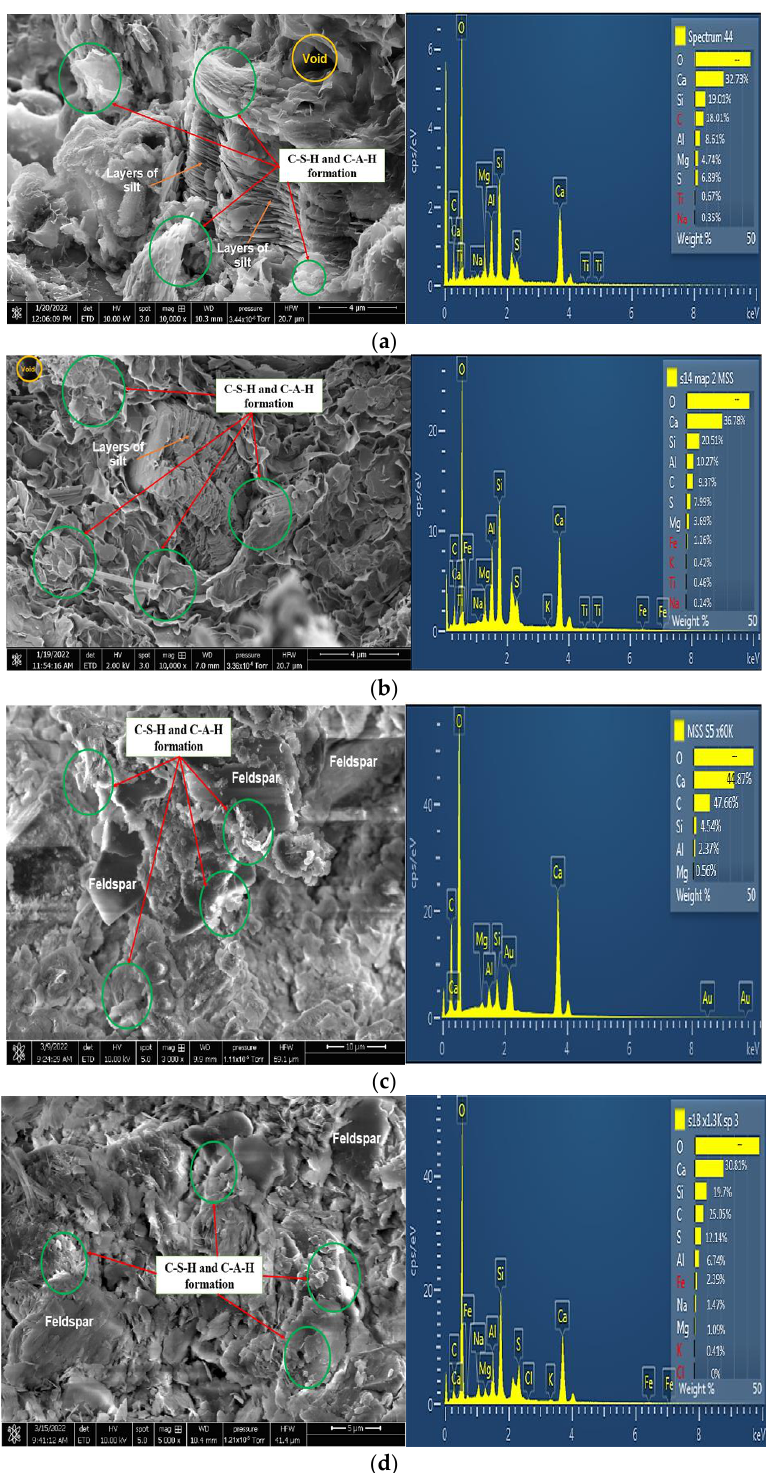
Figure 8. ( a ) SEM and EDX results for subgrade 1 composed of 11.75% GGBS and 11.75% BDW after 28 days curing. ( b ) SEM and EDX results for subgrade 2 composed of 11.75% GGBS and 11.75% BDW after 28 days curing. ( c ) SEM and EDX results for subgrade 1 composed of 23.5% GGBS after 28 days curing. ( d ) SEM and EDX results for subgrade 2 composed of 23.5% GGBS after 28 days